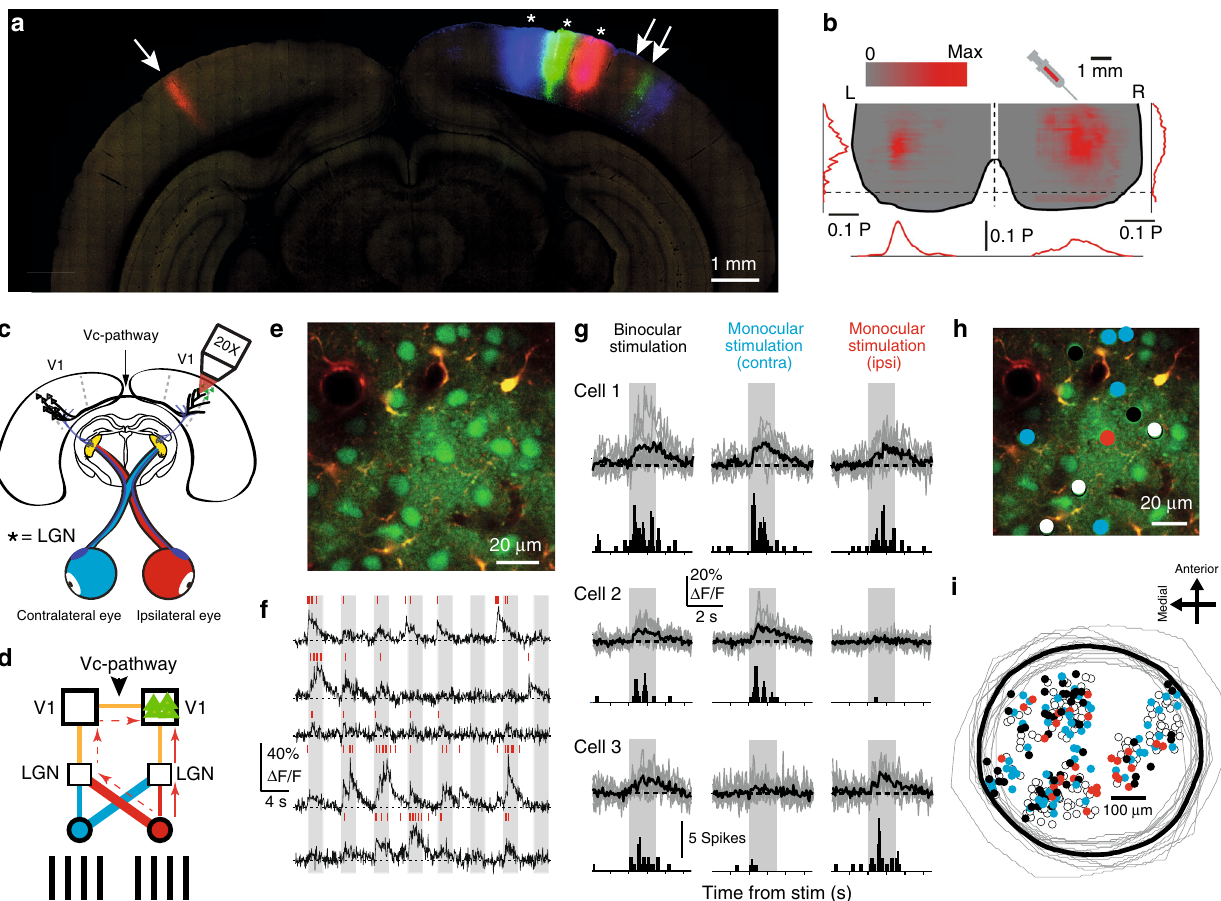
Fig. 1 Localizing the visual callosal pathway and experimental setup. a Coronal section of rat brain showing fl uorescence from CTB-Alexa 594 (red), CTB-Alexa 488 (green), and CTB-Alexa 647 (blue) dyes injected into rat visual cortex (asterisks) at 4.1, 3.0, and 2.0 mm lateral to midline. Note that injections resulted in retrograde labeling of contralateral neurons (red, white single arrow), and retrograde labeling of neurons in V2 (red, green, blue, white double arrow). b Reconstruction of left and right occipital poles showing average regions of retrograde labeling of CTB-Alexa 594 showing coronal and sagittal pixel intensity distributions ( N = 3 animals). c Schematic of experimental design. d Visual stimulation convention showing major visual pathways from eyes (circles) to dorsal LGN (small squares) to cortical V1 (large squares) and visual callosal pathway (vc pathway). Red arrows indicate the two potential anatomical pathways to ipsilateral V1 from the ipsilateral eye, direct via ipsi-LGN (solid) and via the callosal pathway (dashed). e Overview example 2-photon image showing functionally labeled neurons (green) and astrocytes (red). f Both spontaneous (between gray boxes) and evoked (gray boxes) Ca 2 + -transients from fi ve neurons in response to moving gratings at different angles (angles not shown). Inferred spiking activity within an imaging frame (red marks for single APs) and the underlying Ca 2 + -transients shown. g Activity traces from three representative neurons during binocular stimulation (left), contralateral stimulation (middle) and ipsilateral stimulation (right). Calcium responses to single stimuli are overlaid (gray) with average (black) and inferred-spike PSTH (lower to each trace). Binocular neuron (cell 1), contralateral stimuli responsive monocular neuron (cell 2) and ipsilateral stimuli responsive monocular neuron (cell 3). h Overview example 2-photon image (same as e ) labeled with response types within a fi eld of view, non- responders (white), contralateral stimuli responsive monocular (turquoise), ipsilateral stimuli responsive monocular (red) and binocular (black). i Neuronal response type maps overlaid using intrinsic image responses ( N = 17 animals, 22 non-overlapping imaging areas, contains example shown in h ). Each intrinsic imaging area (gray) was centered and associated imaged population overlaid, average intrinsic border